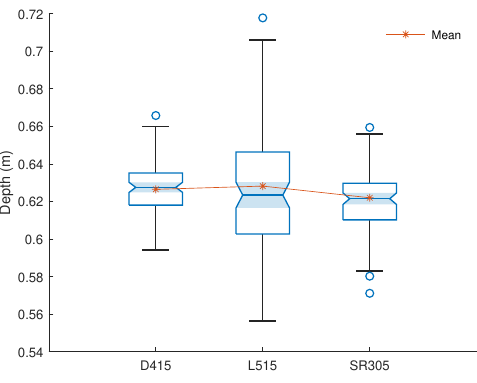
Figure 7. Normal Distributions - D415